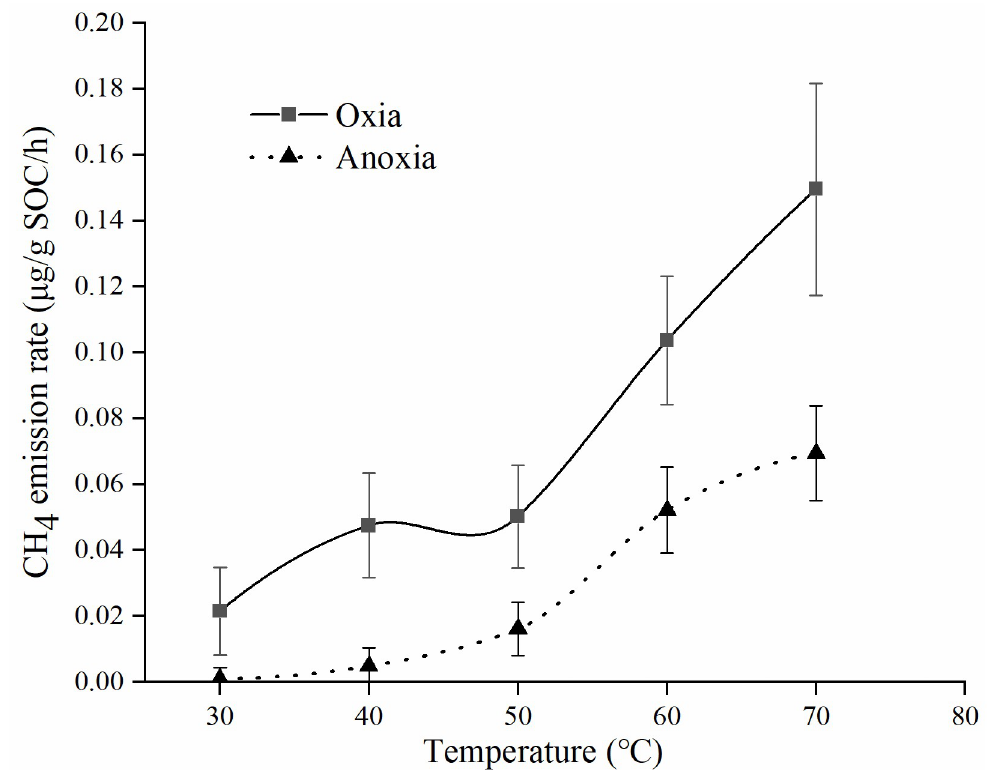
Fig 3. The emission rates of NM-CH 4 at different incubation temperature from 30˚C to 70 ˚C and under aerobic and anaerobic